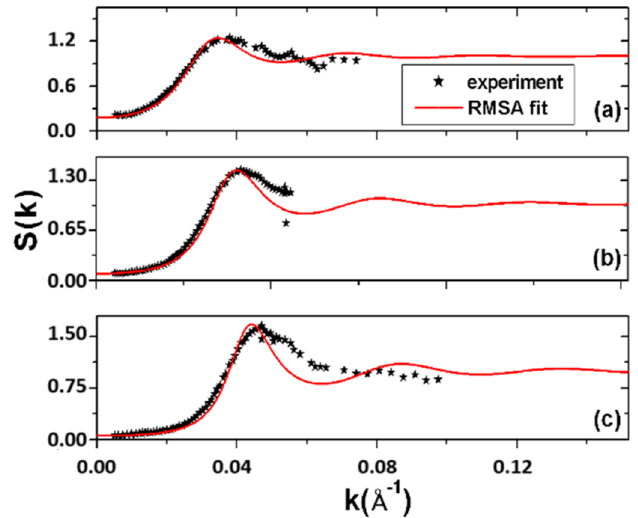
Figure 5. Theory of RMSA with continuous lines fits the experimental 𝑆(𝑘) at three magnetic colloid volume fractions ϕ ; 0.097, ( a ), 0.158 ( b ), 0.203 ( c ). Data with symbols ★ reported by Meriguet, G. et al. [4]. Adapted with permission from Ref. [4]. Copyright 2022 Elsevier Science & Technology journals.